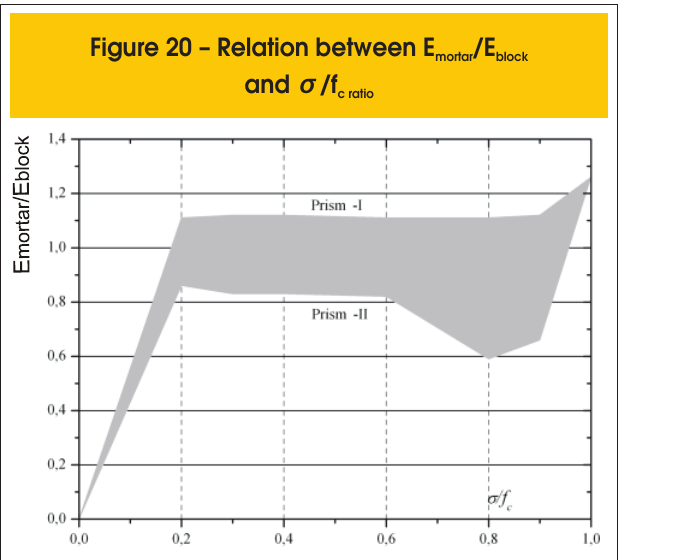
Figure 20 – Relation between E /E mortar block and σ /f c